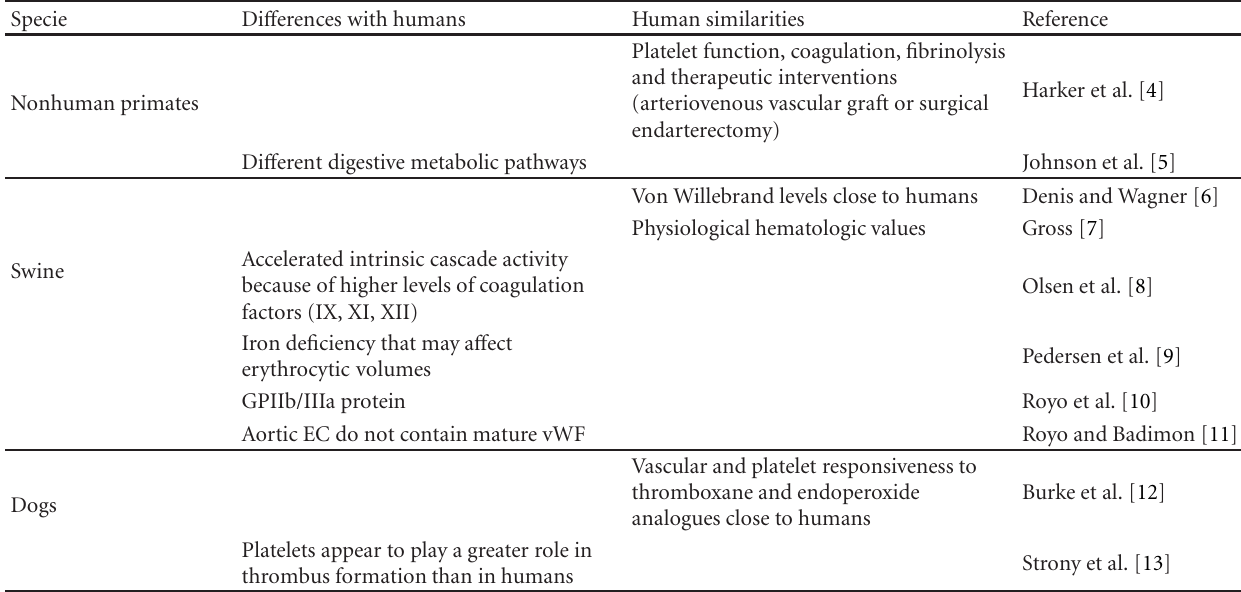
Table 1: Di ff erences between large animal models and humans in the thrombotic system and other parameters that may influence anti- thrombotic e ff